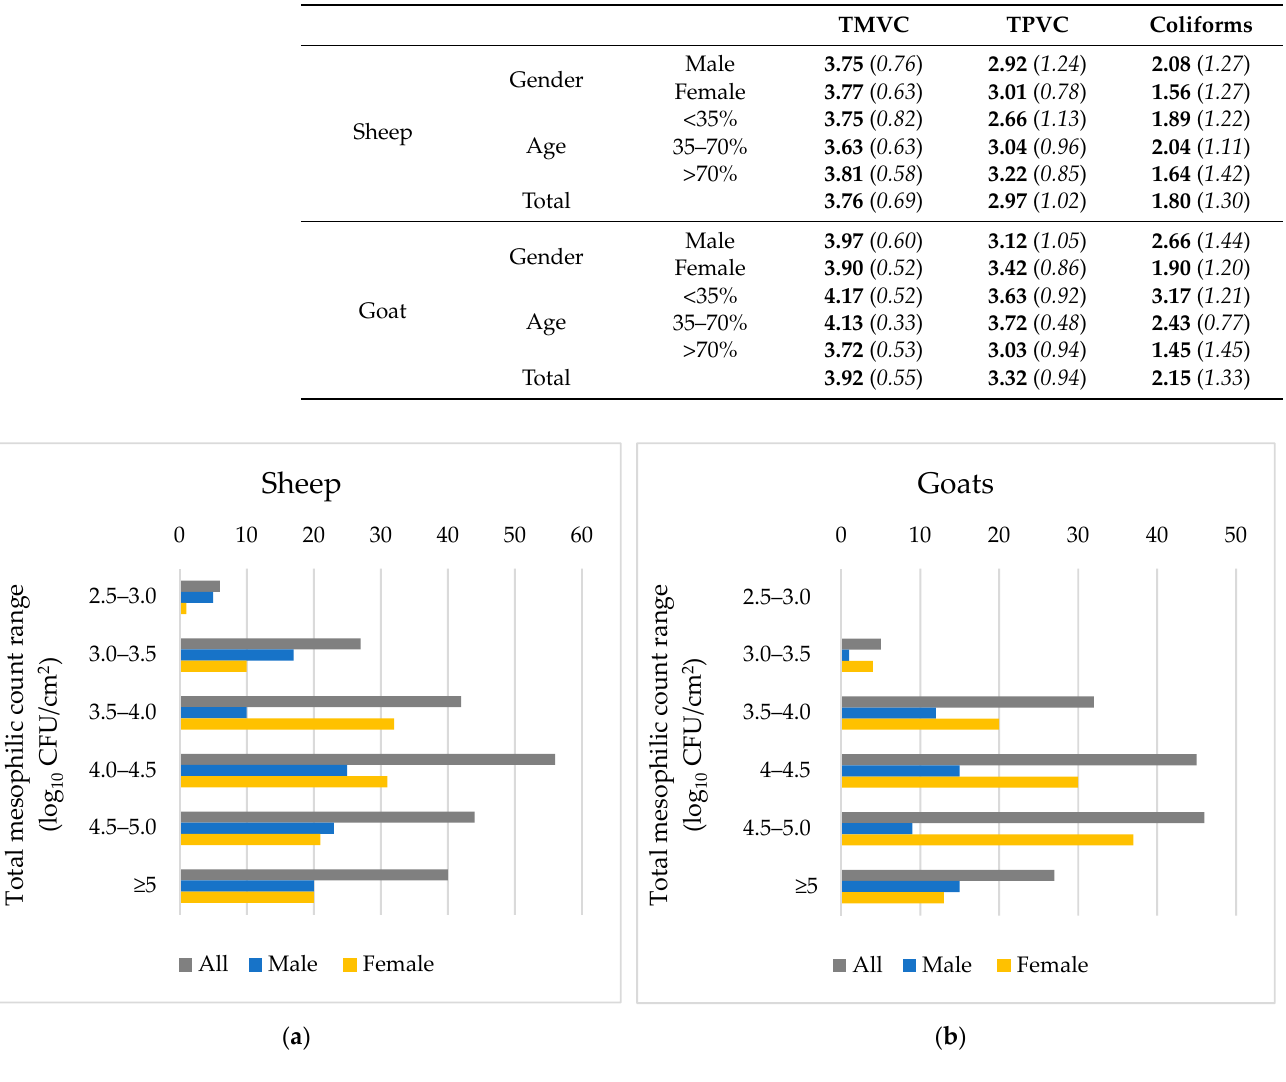
Table 3. Microbial counts of sheep and goat carcasses (in log 10 CFU/cm 2 ), based on gender and age (average in bold, standard deviation in parentheses and italics).